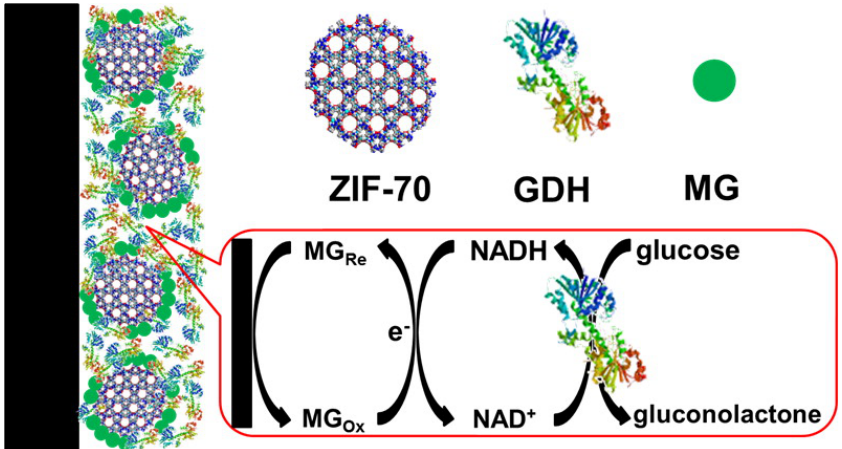
Figure 6. Schematic of the design of ZIF-70-based electrochemical biosensor. Reproduced from [46] with permission from American Chemical Society, copyright 2013. with permission from American Chemical Society, copyright